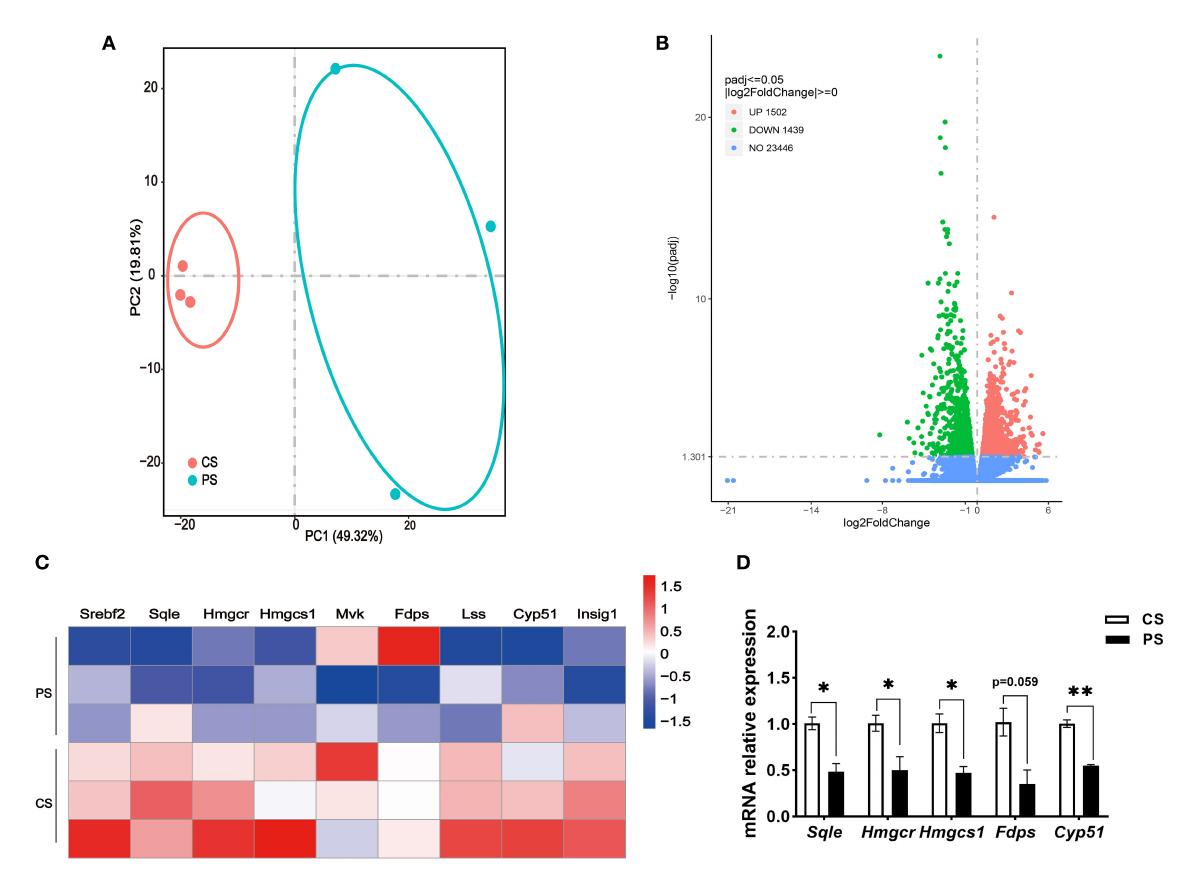
FIGURE6 Response of the lung transcriptome to phytosterols intakes. (A) Principal component analysis (PCA) score plots of the whole transcriptomic dataset in the lung. Each dot represents an observation (animal) projected onto the first (horizontal axis) and second (vertical axis) PCA variables. (B) Volcano plot of differentially expressed genes in the lung of mice in the CS and PS group. Colors indicate p < 0.05 and fold change > 1 (red), p < 0.05 and fold change < 1 (green), and nonsignificant (blue). (C) Heatmap of genes involved in cholesterol synthesis in the lung of two dietary group mice. (D) Validation of gene expression derived from RT-qPCR assay. n = 3 mice/group, the results are presented as the mean ± SEM, representative of three independent experiments, * p < 0.05, ** p <